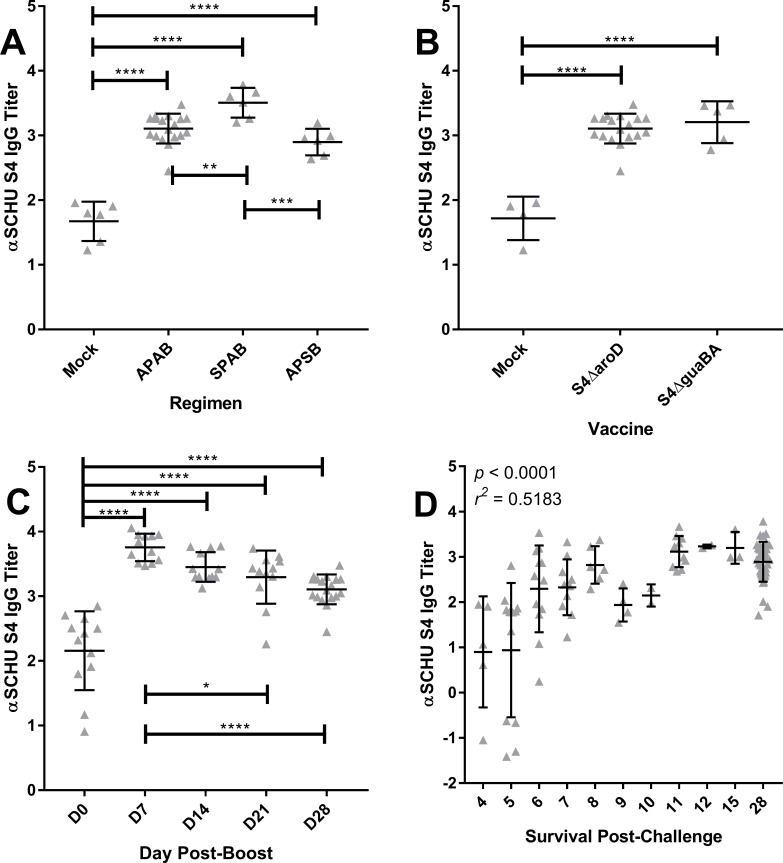
Pre-challenge plasma IgG response to SCHU S4 in vaccinated rabbits corresponds with survival after challenge.Rabbits were bled post-vaccination and the plasma antibody response was assessed by ELISA. Values shown are the median effective concentration (EC50) values for plasma IgG responses against heat-killed SCHU S4 in rabbits. Statistical tests were done by one-way ANOVA. A) day 28 post-vaccination plasma IgG responses to rabbits vaccinated with S4ΔaroD by aerosol prime, aerosol boost (APAB), scarification prime, aerosol boost (SPAB) or aerosol prime, scarification boost (APSB)(n = 6/group). Results from mock-vaccinated rabbits. ** indicates a statistically significant difference by ANOVA, p = 0.0067; *** indicates a significant difference, p = 0.0006; **** = highly significant differences, p<0.0001. B) Graph shows comparison between plasma IgG titers on day 28 post-vaccination for rabbits vaccinated by APAB with S4ΔaroD (n = 12) or S4guaBA (n = 6). Mock-vaccinated rabbits are shown for comparison; **** = highly significant differences, p <0.0001. C) change in plasma IgG titers over time for S4ΔaroD; days shown are post-vaccination; * = significant difference, p = 0.0215; **** = highly significant differences, p <0.0001.One-way ANOVA analysis was used to determine significant differences between pre- and post-vaccination bleeds; * = significant, p <0.05, **** = highly significant, p<0.0001. D) Graph shows day 28 post-vaccination (day -2 relative to challenge) IgG titer (y-axis) compared to survival time (in days) after aerosol challenge with SCHU S4 (x-axis) across all vaccine groups from all studies conducted to date including mock-vaccinated rabbits (n = 107 rabbits, including studies reported here and [35, 36]). ANOVA analysis indicated a linear trend in which higher plasma IgG responses to SCHU S4 predicted longer survival time in days (p = 0.0001, r2 = 0.5183).